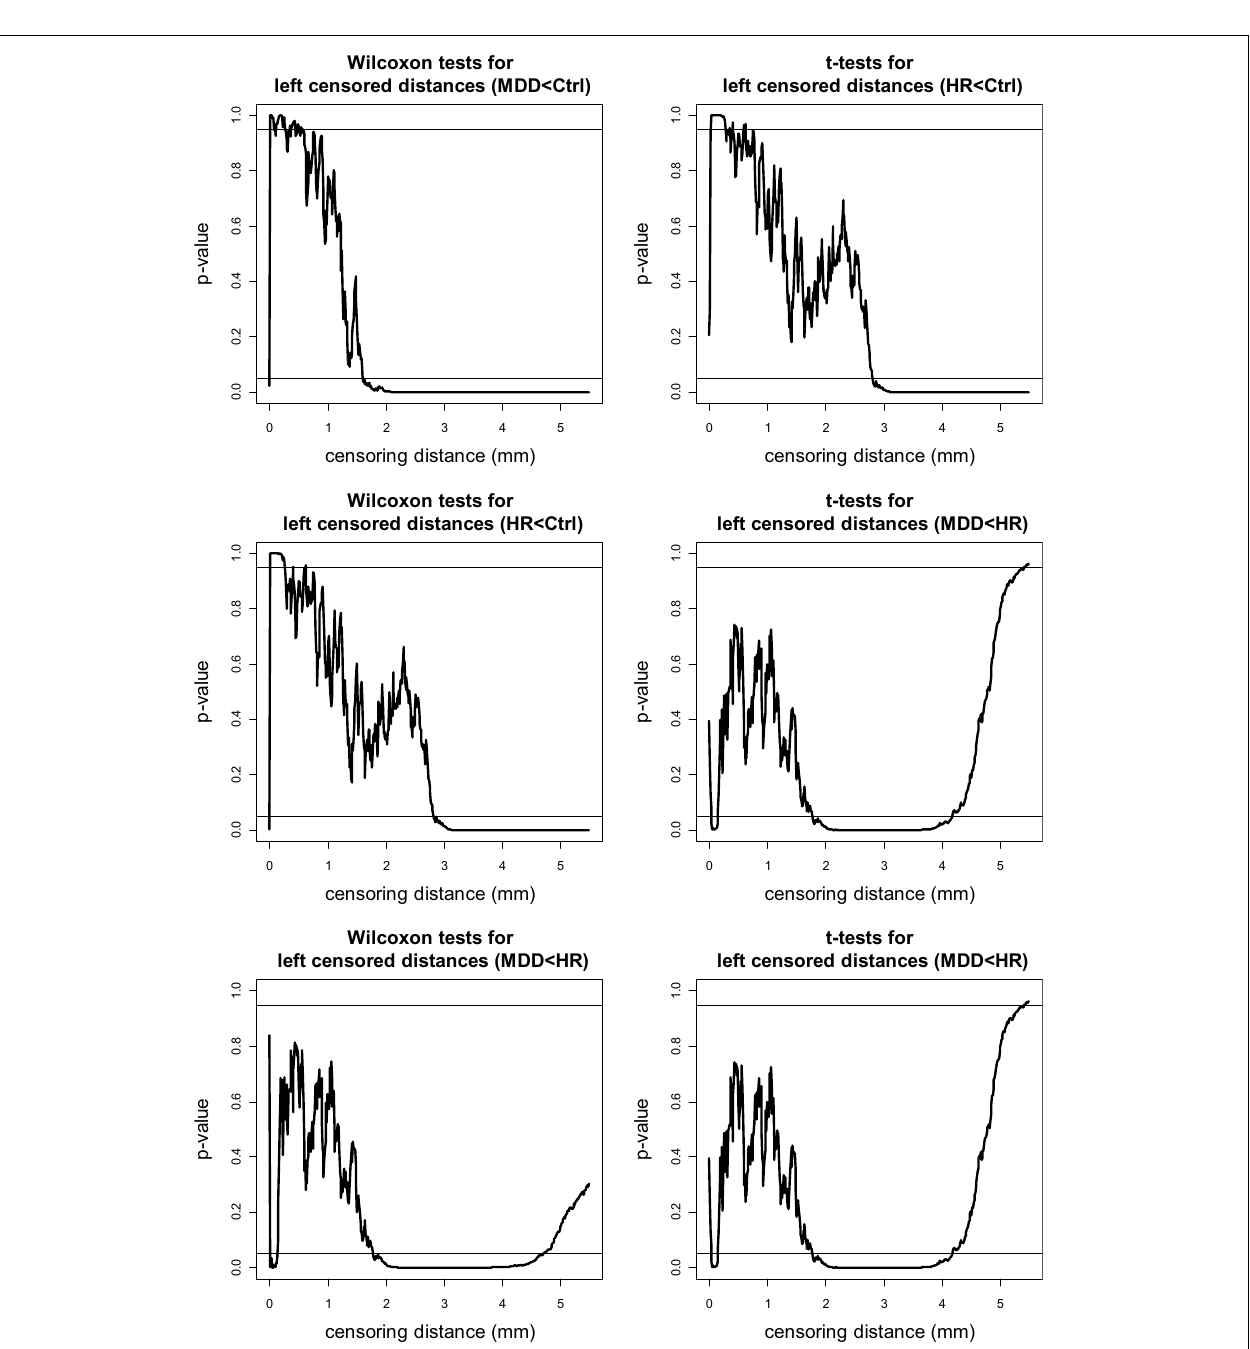
FIGURE 4 |The p -values versus censoring distance values (millimeter) for pairwise comparisons of leftVMPFC distances withWilcoxon rank sum test (left) and t -test (right) for the less than alternative . Horizontal lines are located at 0.05 and 0.95. < : the alternative for “first less than second”; > : the alternative for “first greater than